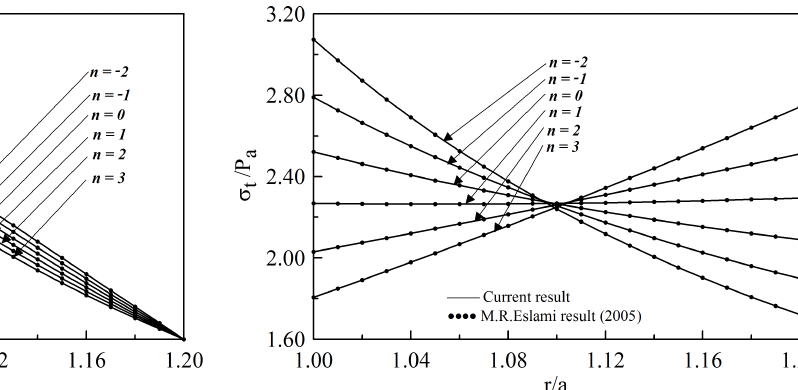
Figure 9: Radially distributed tangential stress